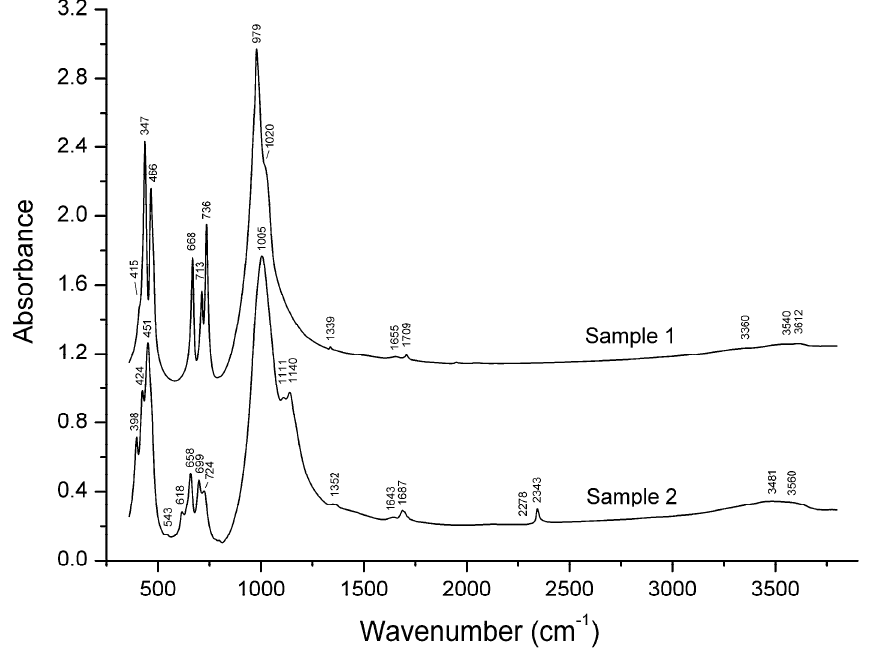
Figure 6. Infrared absorption spectra of the sulfate-rich minerals belonging to the haüyne–lazurite solid-solution series (Samples 3 to 5).